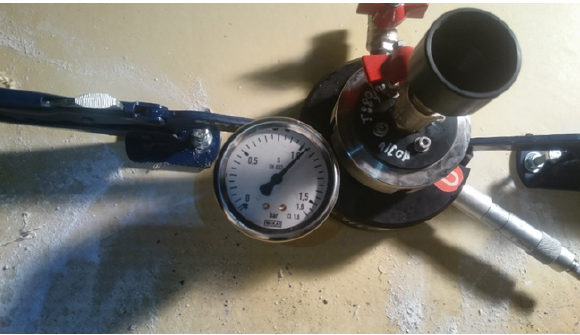
Figure 15: Sample test using the GWT